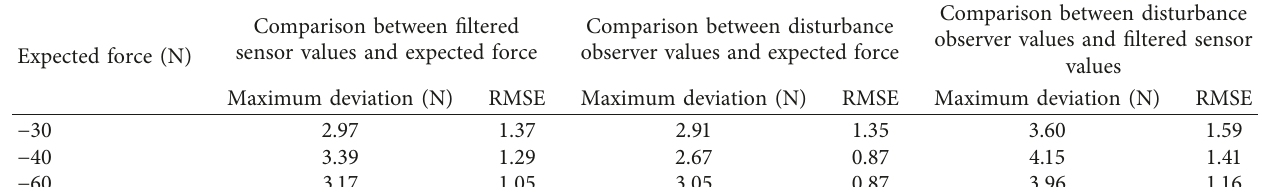
Table 3: Comparison of experimental data.